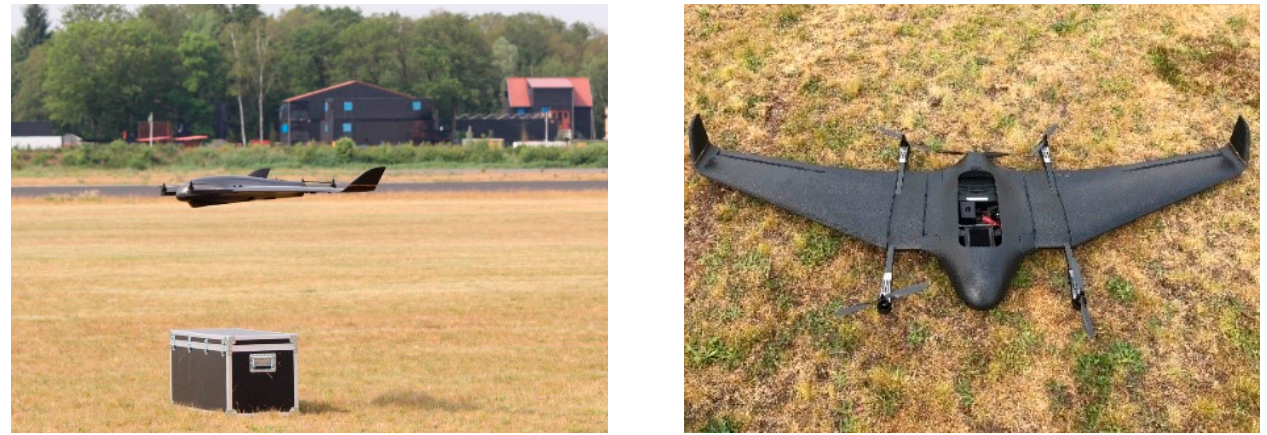
Figure 2. Vertical Technologies’ DeltaQuad Pro (www.deltaquad.com accessed on 28 January 2022).